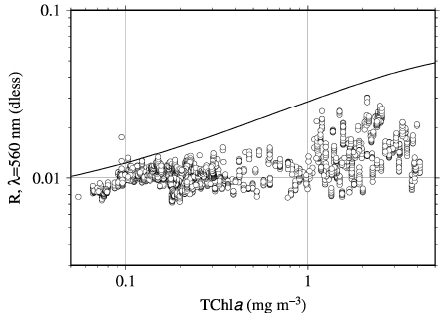
Figure 5. Irradiance reflectance at 560 nm, R(560), as a function of [TChl -a ]. The points are from 3 years of clear-sky quality-checked buoy measurements taken within one hour of solar noon. The curve is the upper limit for Case-1 waters [32] (adapted from [28]).